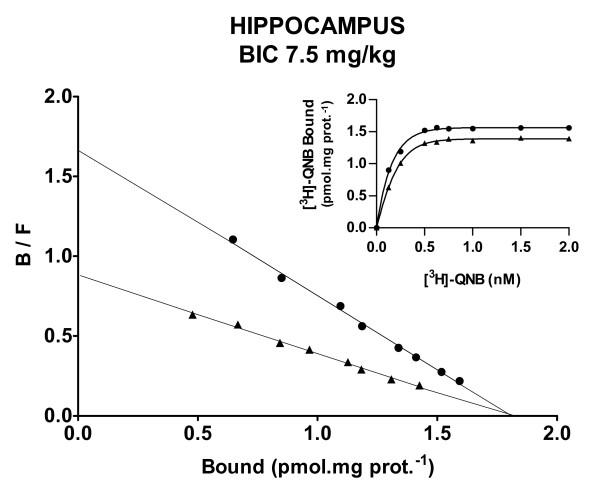
Scatchard plots for [3H]-QNB binding to rat hippocampal membranes at equilibrium after administration of a convulsant BIC dose (7.5 mg/kg). Results are from a single experiment representative of a set of three, each performed in duplicate. Inset, saturation curves. (●) Control; (▲) BIC seizure.